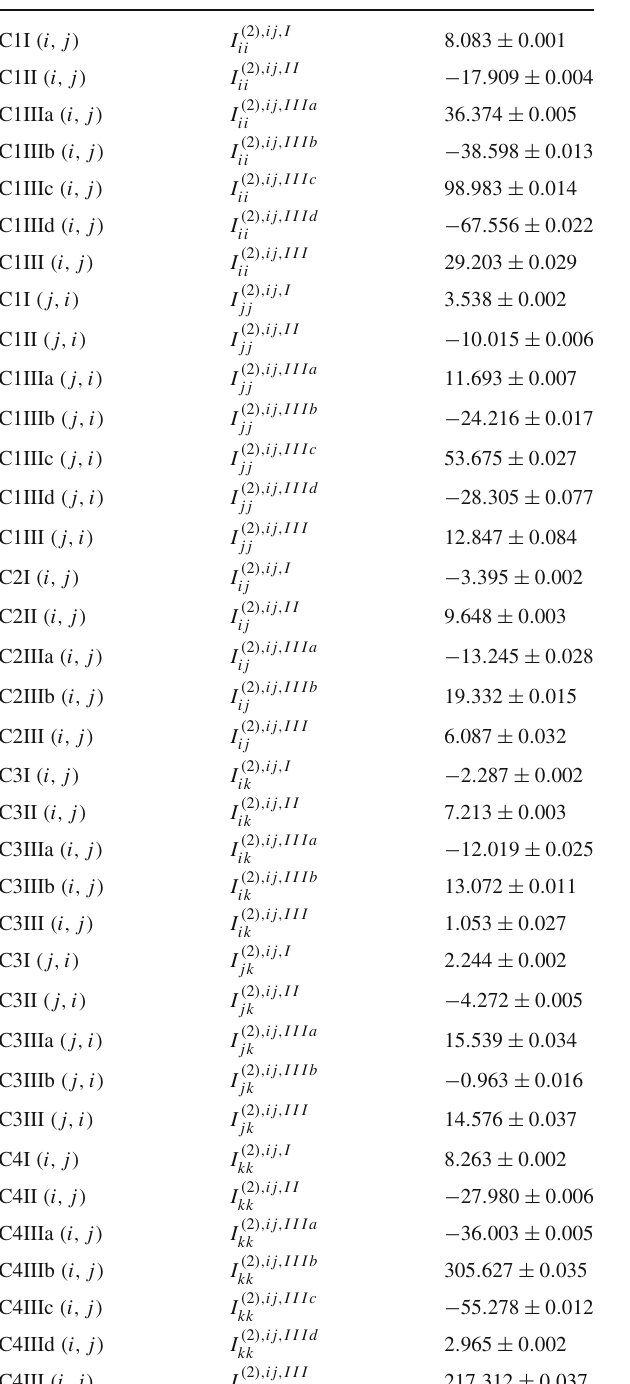
This result agrees with the literature (c.f. Eq. (173) of Ref. [57] and Eq. (2.23) of Ref. [58]). The more general result of Eq. (E.47) can be used for ep or e + e − processes with respectively one or two final-state